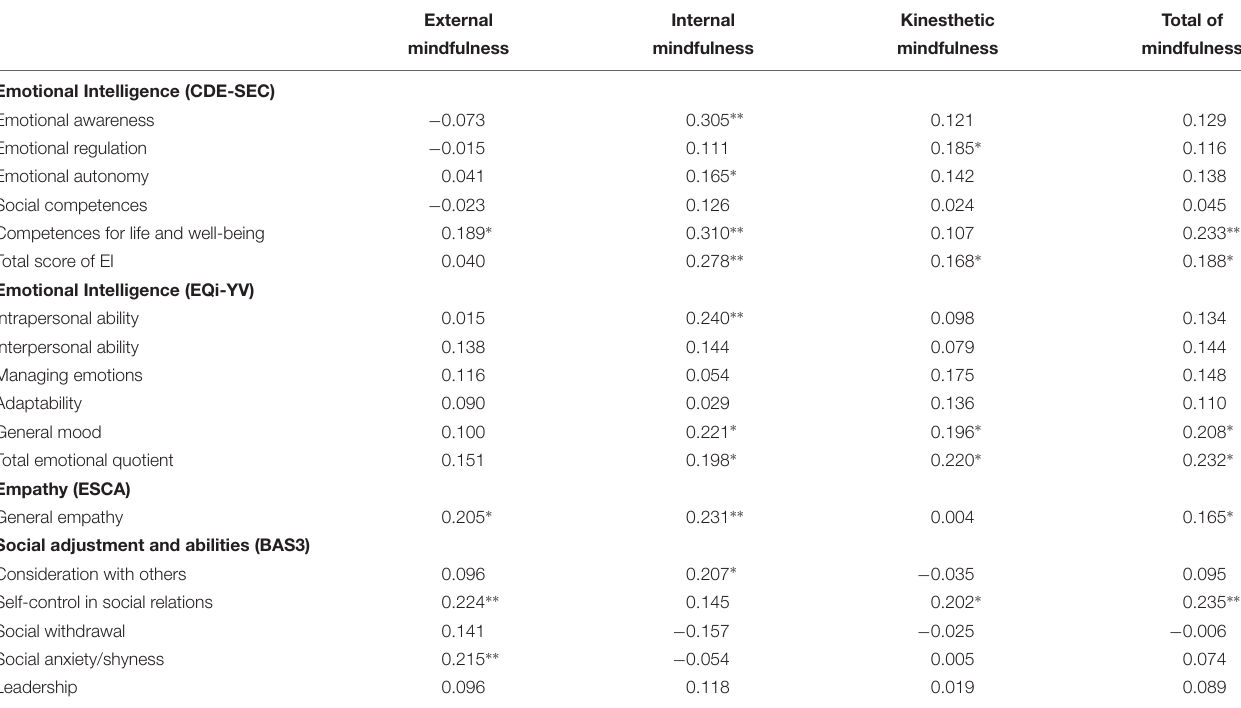
TABLE 2 | Bivariate correlation scores.